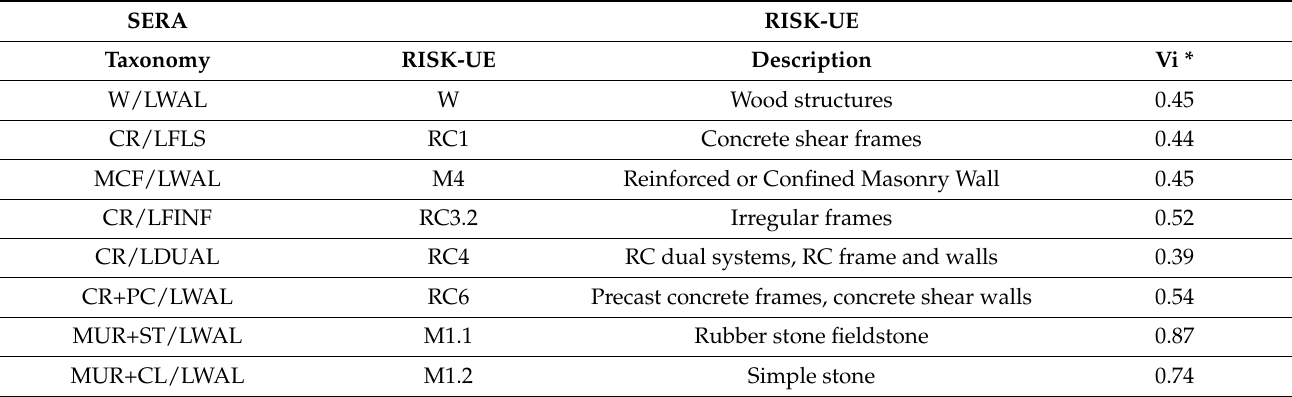
Table 2. The taxonomies in the Luchon area according to SERA, the corresponding acronym in RISK-UE and the associated Vi. * Vi—vulnerability index.